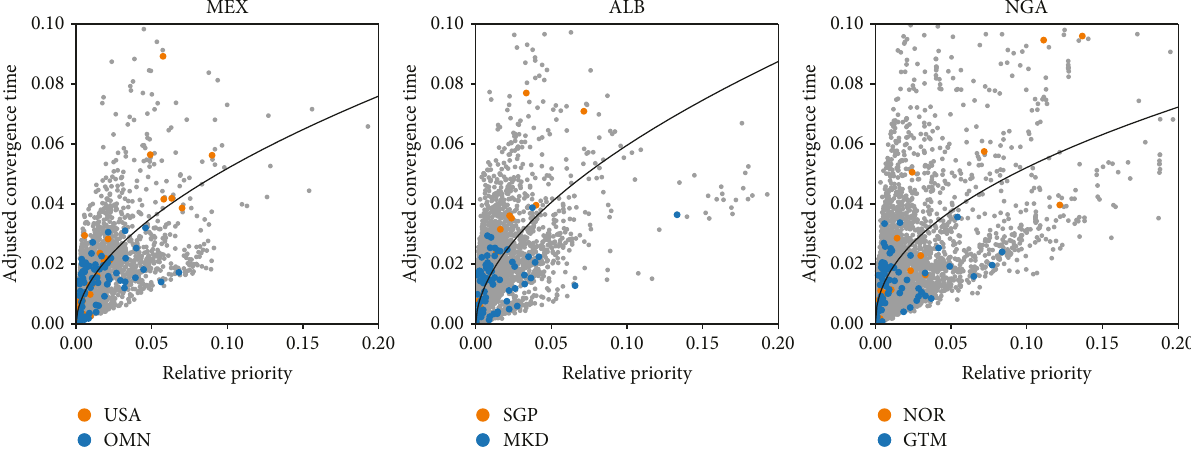
Figure 6: The most (blue) and the least (orange) resilient development modes for three countries. The majority of orange dots are not visible because they are covered by the blue ones. Gray dots refer to other development